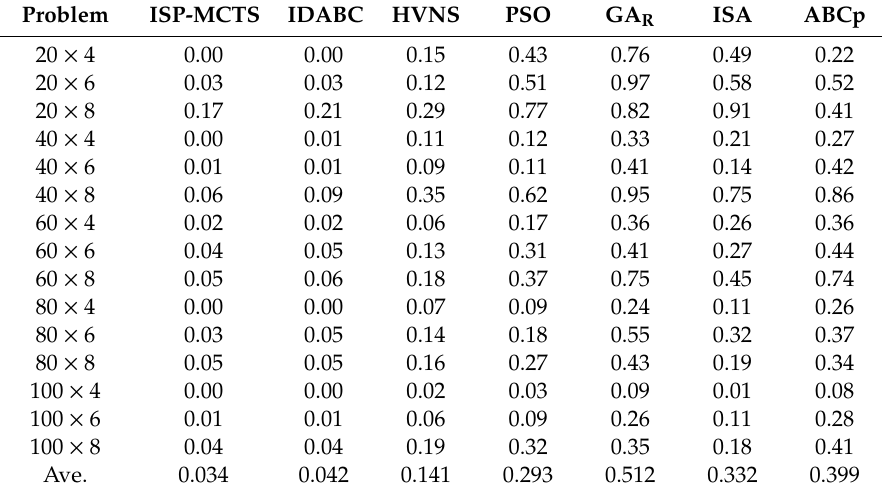
Table 11. Computational results of the algorithms ( ρ = 30).